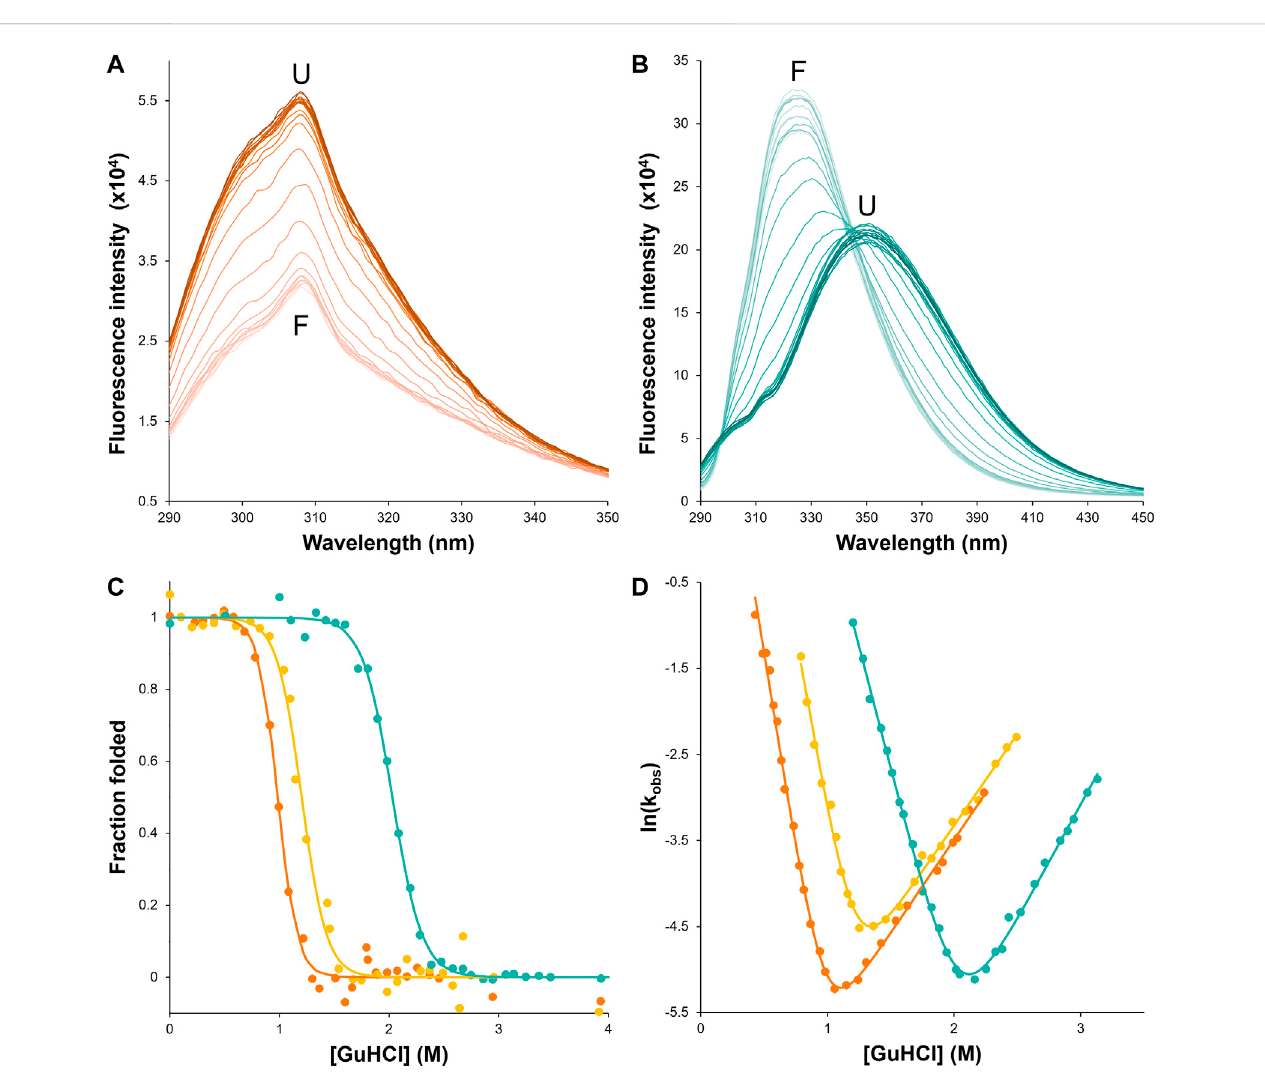
FIGURE 4 csHisH90GdisplayssuccessfulkineticstabilizationoverHisH90G.Fluorescenceemission spectraofunfoldingequilibriafor (A) wtHisand (B) csHisH90G in0 – 4 MGuHCl(darkercolorindicateshigherdenaturantconcentration).csHisH90Gshowsapronouncedredshiftfromthefoldedstate(F)at325 nmtothe unfolded state (U) at ~350 nm. (C) Fluorescence-monitored GuHCl denaturation curves displayed as the fraction of folded protein for wtHis (orange), HisH90G (yellow), and csHisH90G (cyan). Solutions contained 50 mM potassium phosphate pH 7.7, 0 – 4 M GuHCl, 1 mM DTT, and 10 μ M protein for wtHis and HisH90G or 6 μ M protein for csHisH90G. csHisH90G is signi fi cantly thermodynamically stabilized compared to wtHis and HisH90G. All samples were equilibrated at 27 ° C for at least 10 half-lives. (D) Chevron plots for observed folding and unfolding rate constants for wtHis, HisH90G, and csHisH90G at 27 ° C. wtHis and HisH90G kinetics were monitored at 306 nm with excitation at 277 nm. csHisH90G kinetics were monitored at 314 nm with excitation at 280 nm. csHisH90G is kinetically stabilized compared to its parent protein HisH90G. Data points in (C) and (D) are for single measurements. The results are representative of at least two independent experiments. Values for equilibrium and kinetic fi ts are given in Table 2. Models used to fi t equilibrium and kinetic data are given in